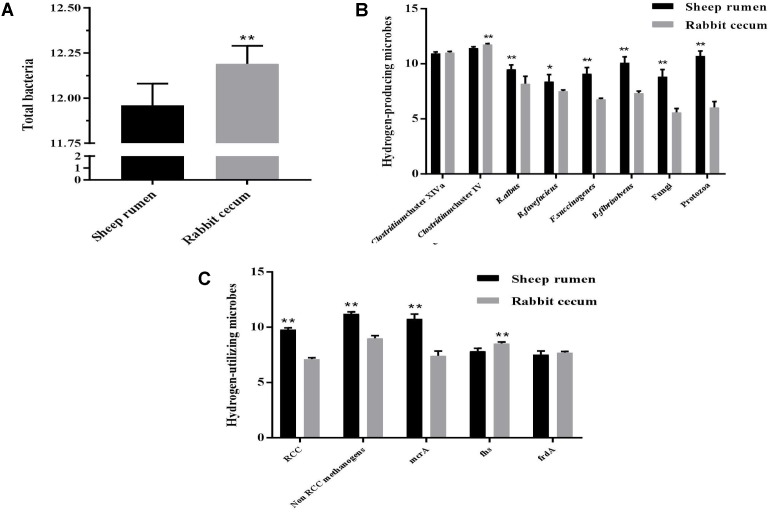
Abundance of select microbes in the sheep rumen (n = 5) and the rabbit cecum (n = 15). (A) Total bacteria; (B) Select hydrogen-producing microbes; (C) Select hydrogen-utilizing microbes. Abundance was expressed as log10 copies of target gene/g freeze-dried digesta sample. Target gene: 16S rRNA gene for bacteria and methanogens (except for mcrA); ITS1 for fungi; 18S rRNA for protozoa; mcrA, methyl-CoA reductase α subunit gene; fhs, Formyltetrahydrofolate synthetase gene; frdA, Fumarate reductase gene α subunit gene. ∗∗P < 0.01; ∗P < 0.05.